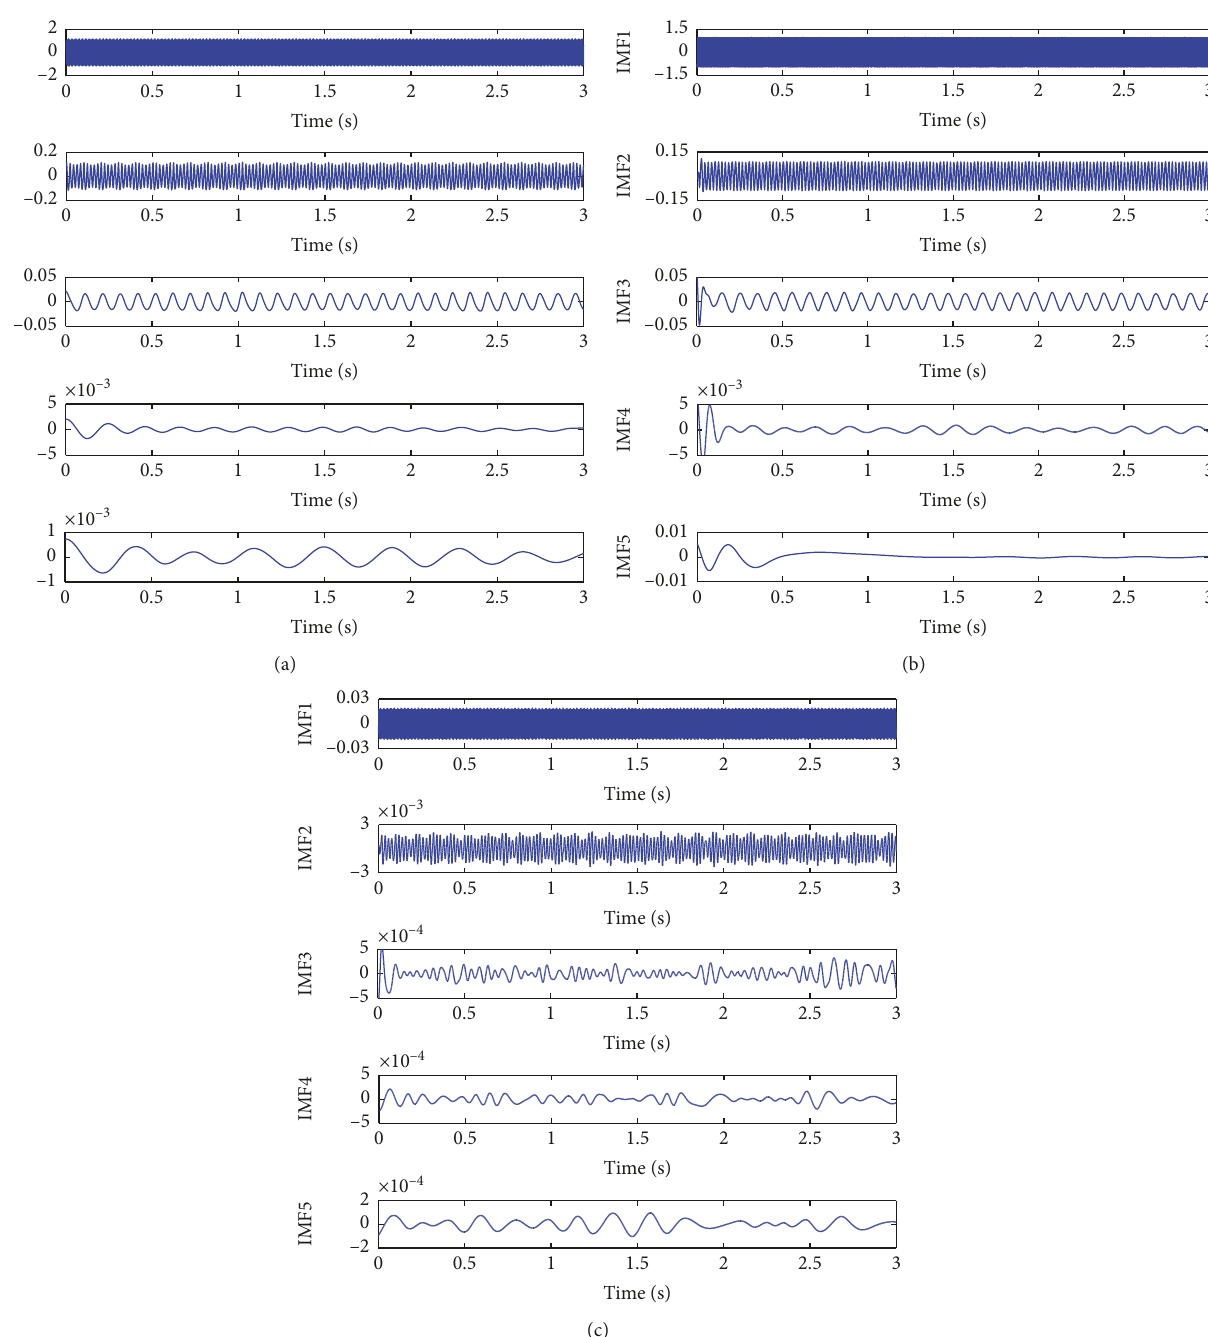
Figure 4: EMD results of three types of piezoelectric patch signals: (a) normal piezoelectric patch; (b) broken piezoelectric patch; (c) degummed piezoelectric